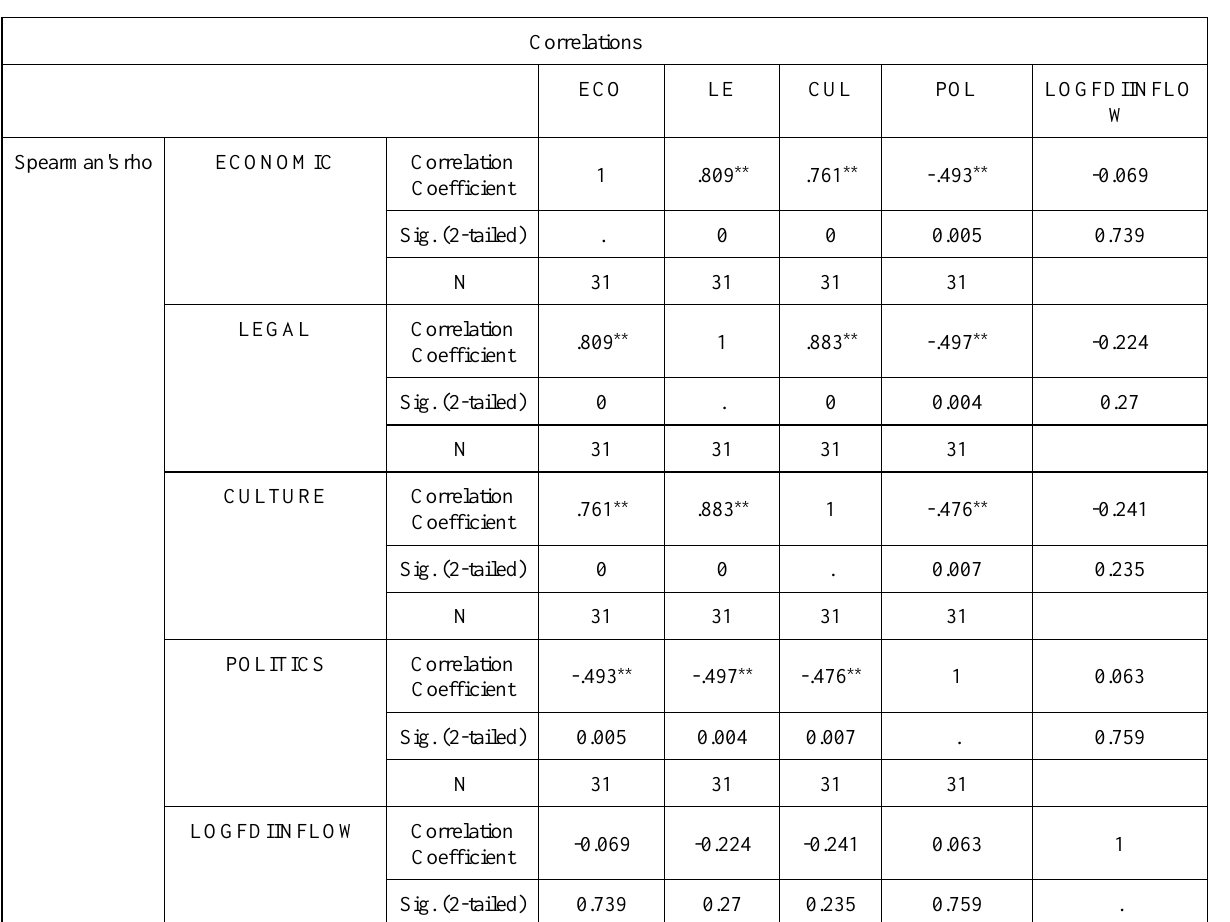
Table 4. Influencing factors